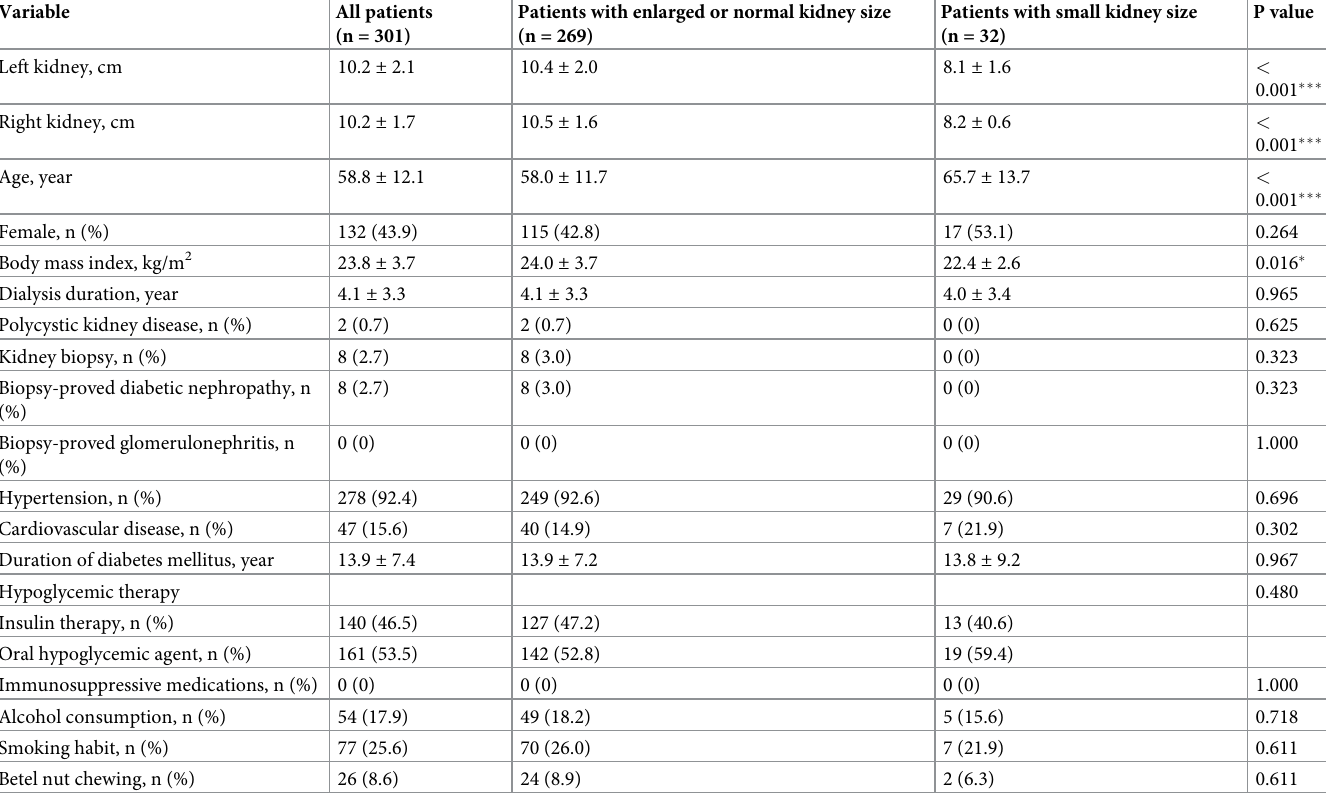
Table 1. Baseline characteristics of diabetic patients receiving hemodialysis stratified by kidney size (n =